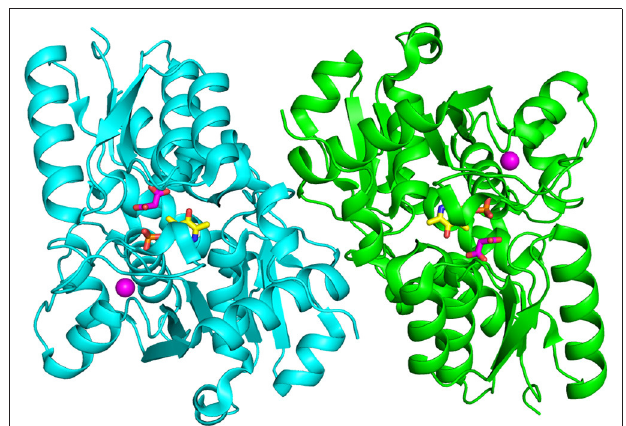
FIGURE 4 | Dimeric structure of hSR (PDB code: 3L6B). The two monomers are represented in cyan and green. PLP and malonate are in sticks, and colored in yellow and pink, respectively. The divalent cation is represented as a pink sphere.